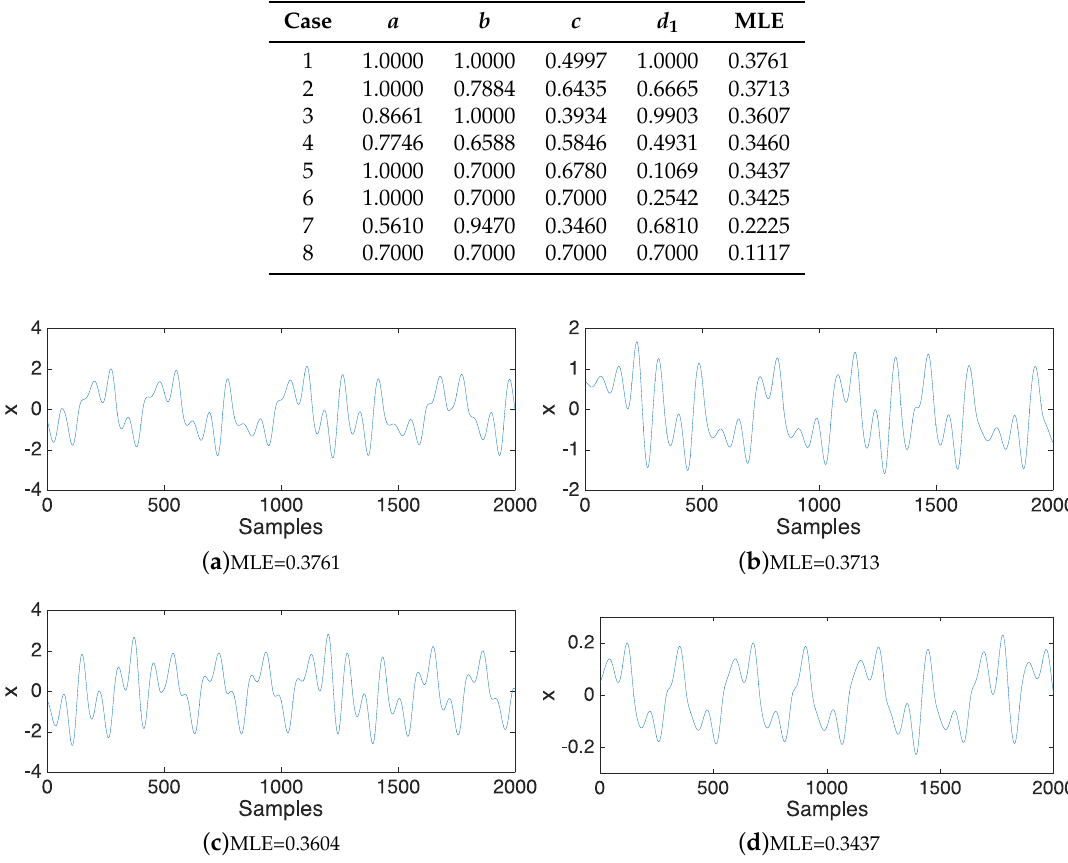
Figure 1. Examples of the chaotic time series with different values of